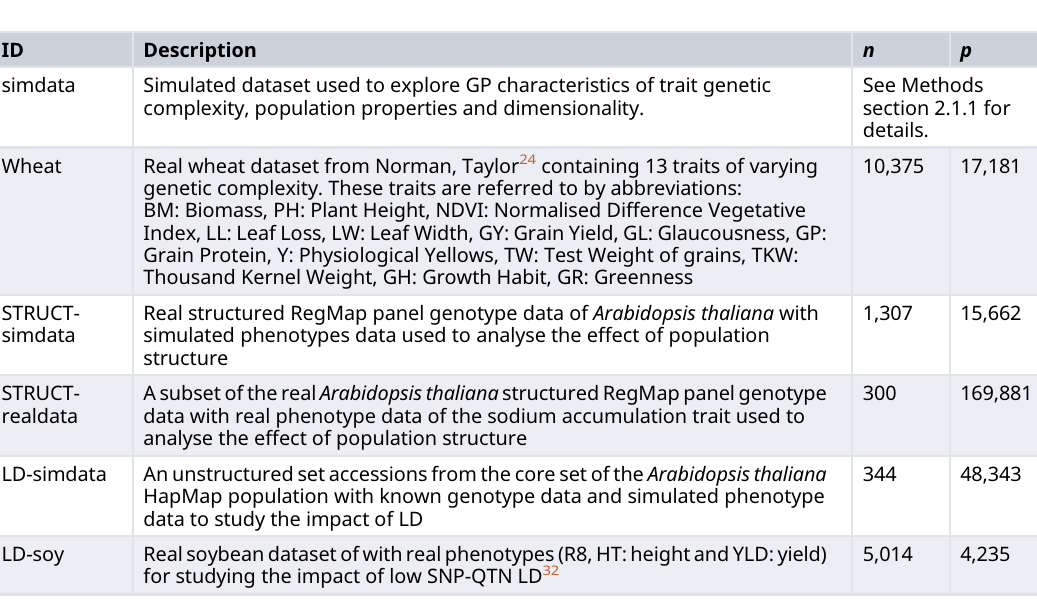
Table 2. List of datasets. 23